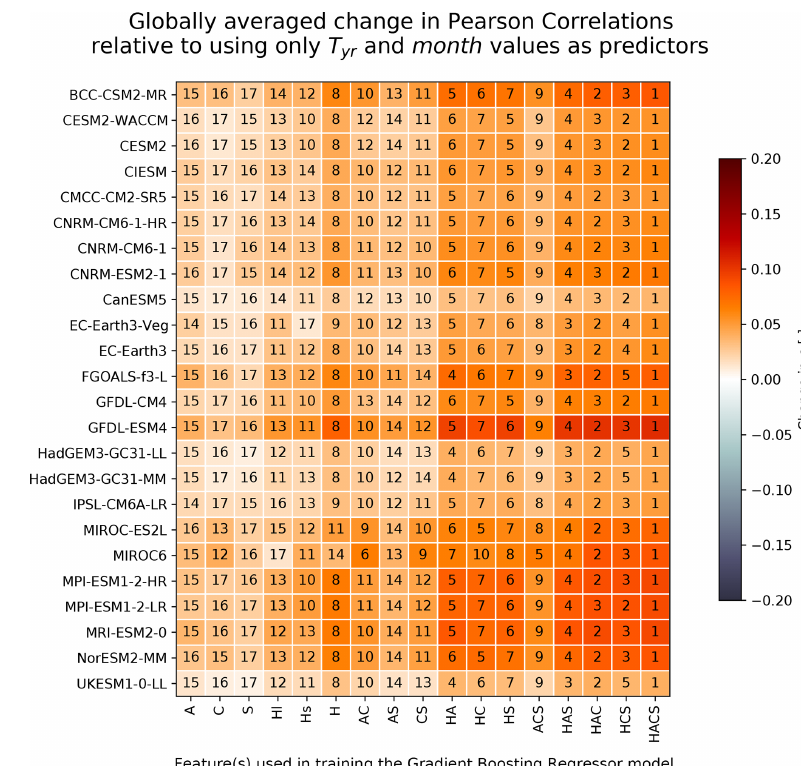
Earth Syst. Dynam., 13, 851–877,